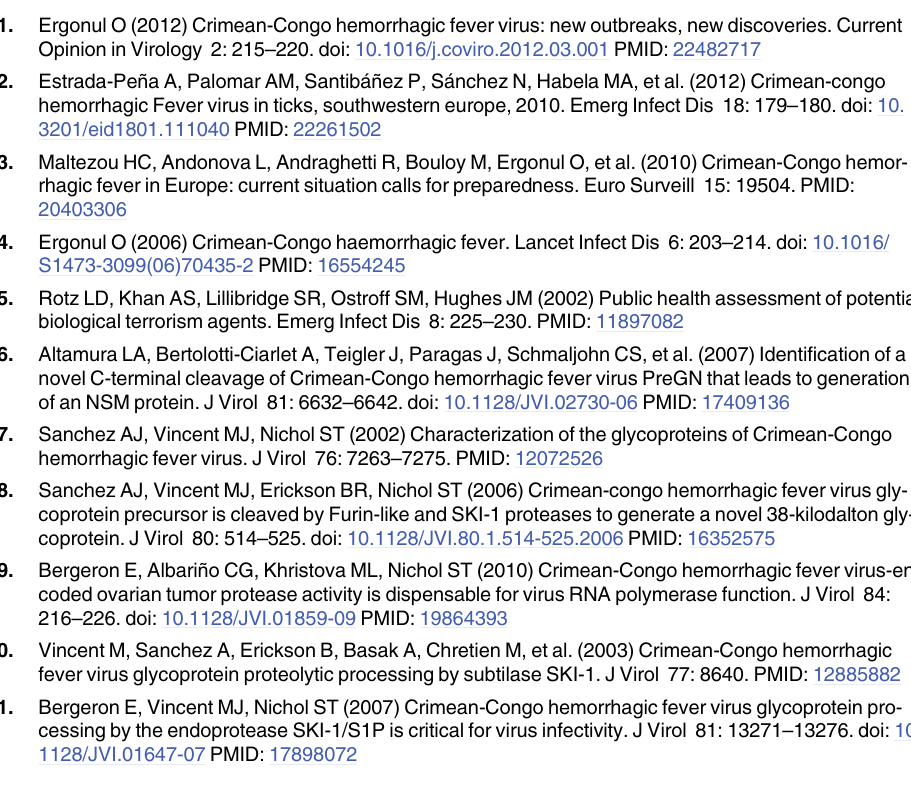
S4 Fig. GP38 is not detectable in lysates of infected cells. Par6 cells were infected with CCHFV-WT or CCHFV-ASKA at MOI of 0.1. Proteins from the cell lysates were separated by NuPAGE (Bis-Tris 4 – 12% gels in MOPS buffer). Membranes were blotted with anti-GP38 (379 – 392) pAb [8]. Note that PreGn is detectable with GP38-specific antibody. S5 Fig. Alignment of glycoprotein precursor regions from various Crimean Congo hemor- rhagic fever virus (CCHFV) strains. Complete sequences of CCHFV strains were aligned using CLC Main Work Bench 7.0. Arrow indicates site of furin-like proprotein convertase (PC) cleavage. The RSKR cleavage motif is completely conserved in all CCHFV